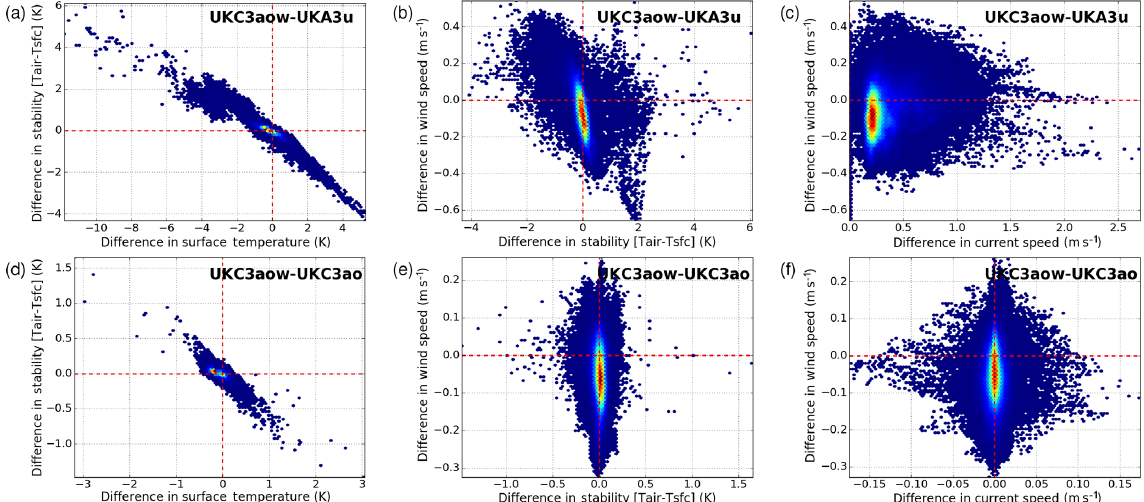
Figure 14. Scatter plots showing relationships between differences in monthly mean results during July 2014 of (a, d) near-surface temper- ature difference (1.5m air temperature − SST) with differences in SST, (b, e) 10m wind speed with near-surface temperature difference and (c, f) 10m wind speed with differences in surface current speed. Plots in (a) – (c) compare mean UKC3aow and UKA3u differences (i.e. fully coupled relative to atmosphere-only simulation). Plots in (d) – (f) compare mean UKC3aow and UKC3ao differences (i.e. fully coupled with wave relative to partially coupled atmosphere–ocean coupled).